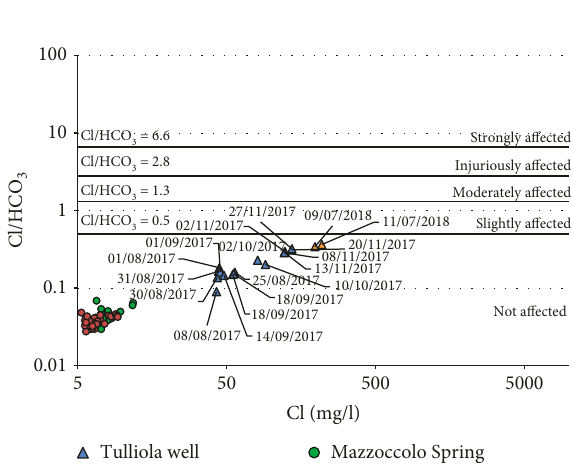
Figure 10: Scatter plot of Cl vs. Ca (a) and Na (b).